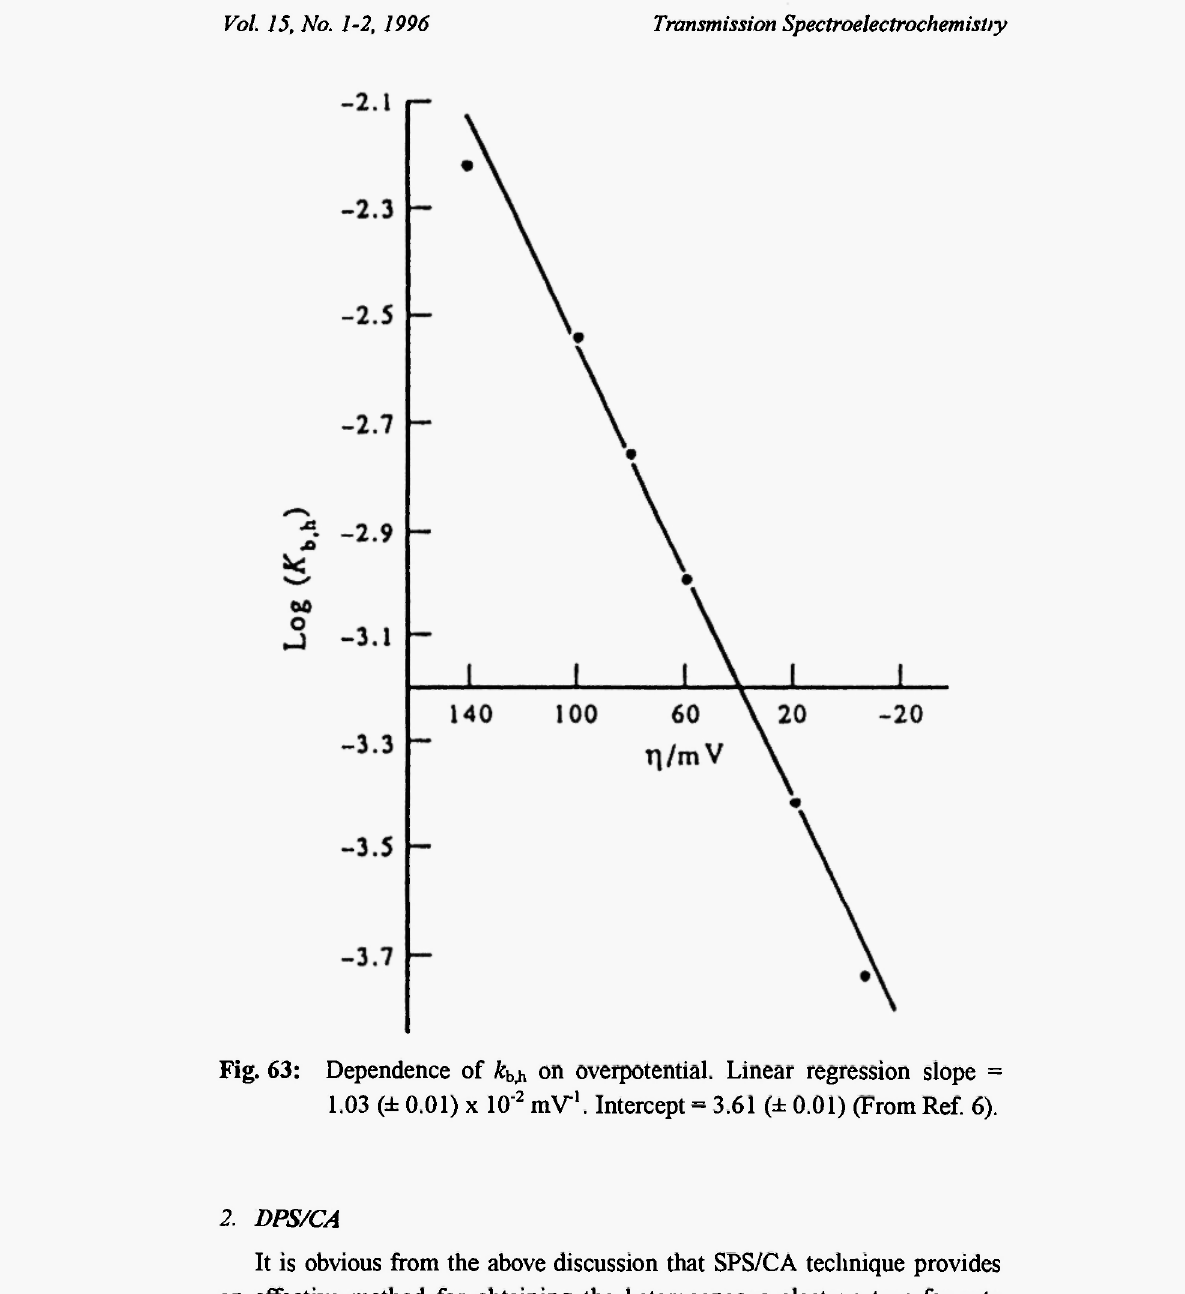
Fig. 63: Dependence of k b<h on overpotential. Linear regression slope = 1.03 (± 0.01) χ 10" 2 mV 1 . Intercept = 3.61 (± 0.01) (From Ref.